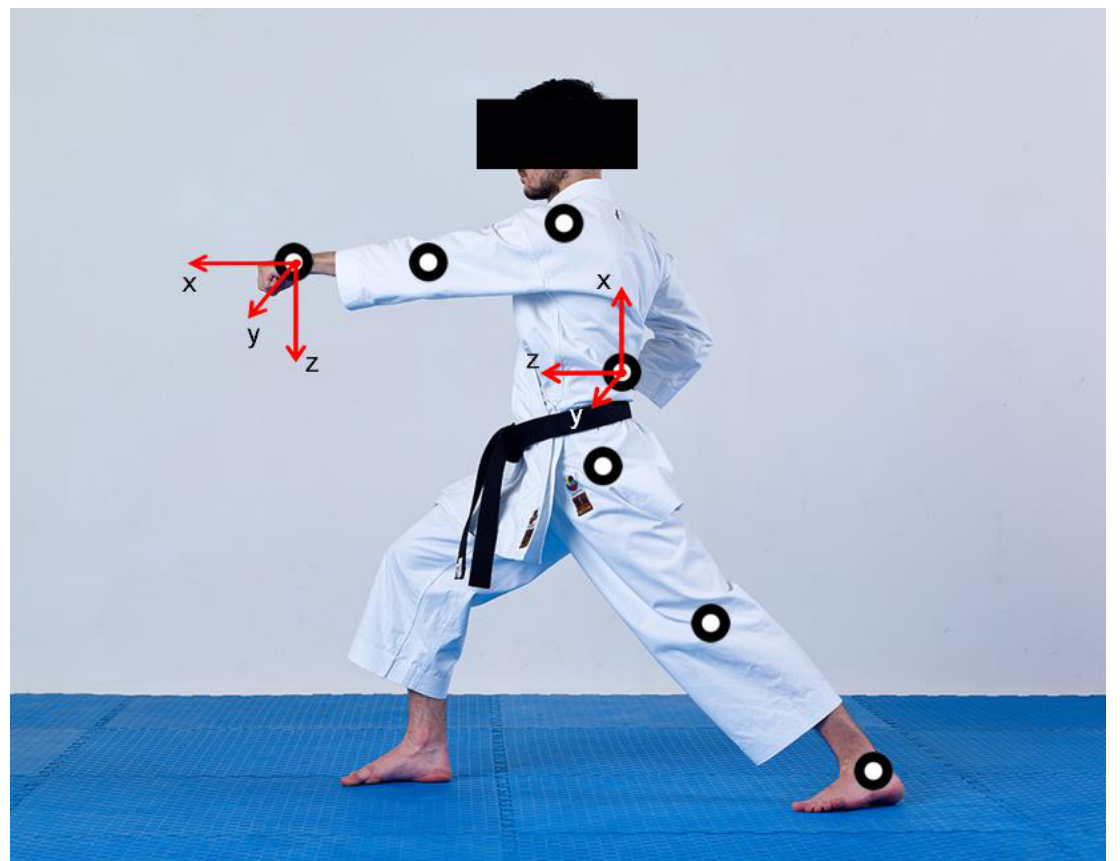
Figure 2. The kinetic chain of a reverse punch and the orientation of the sensors.